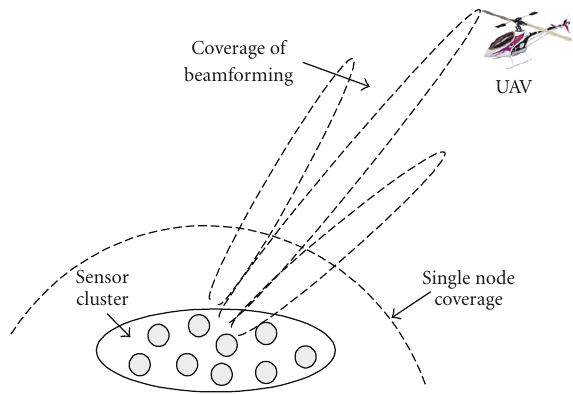
Figure 1: Single node cannot communicate with UAV